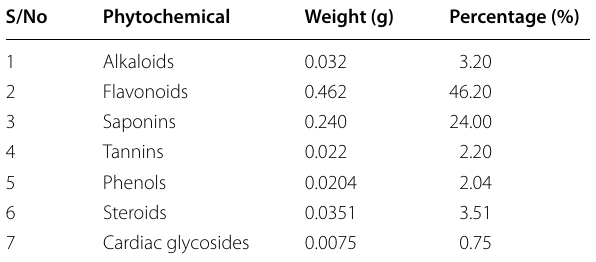
Table 4 Effect of Ipomoea asarifolia ethanolic leaf extract on MES-induced seizures in chicks